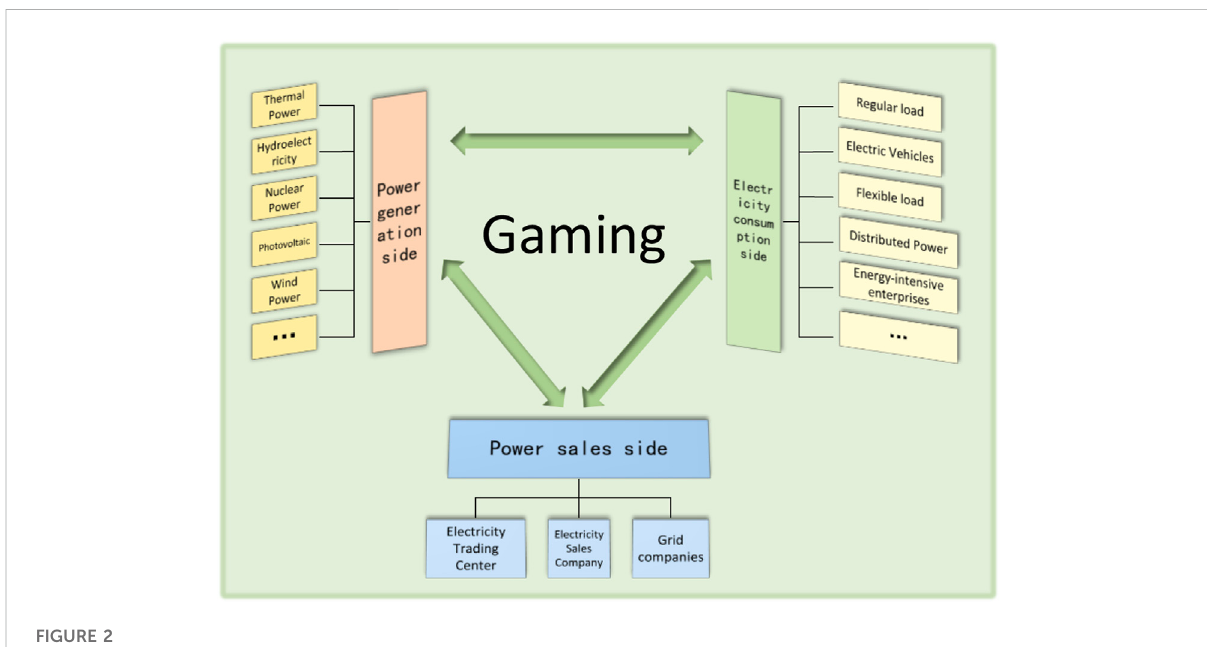
FIGURE 2 Game subject of electricity